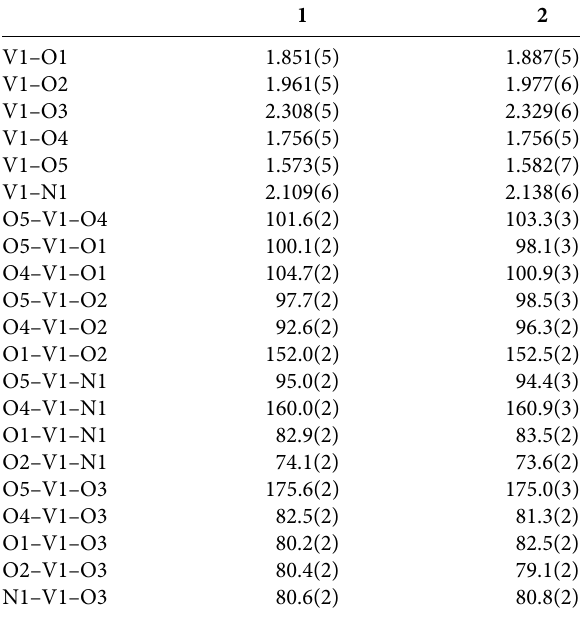
Table 2. Selected bond distances (Å) and angles (°) for the complex- es